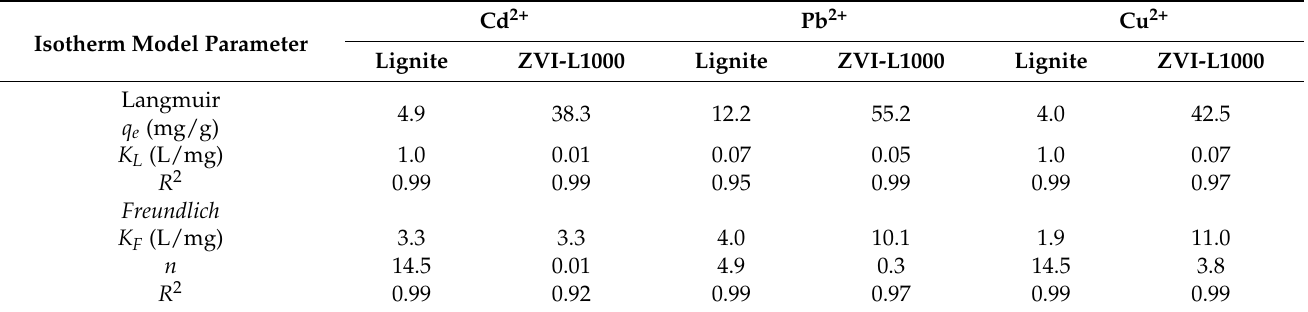
Table 2. Adsorption isotherm parameters for Cd 2+ , Pb 2+ and Cu 2+ removal by lignite and ZVI-L1000.